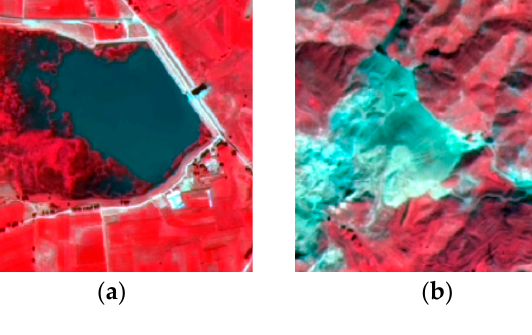
Figure 4. Examples of negative samples in the GF-6 image. ( a ) Water reservoir, ( b ) bare rock, ( c ) bare land, and ( d )